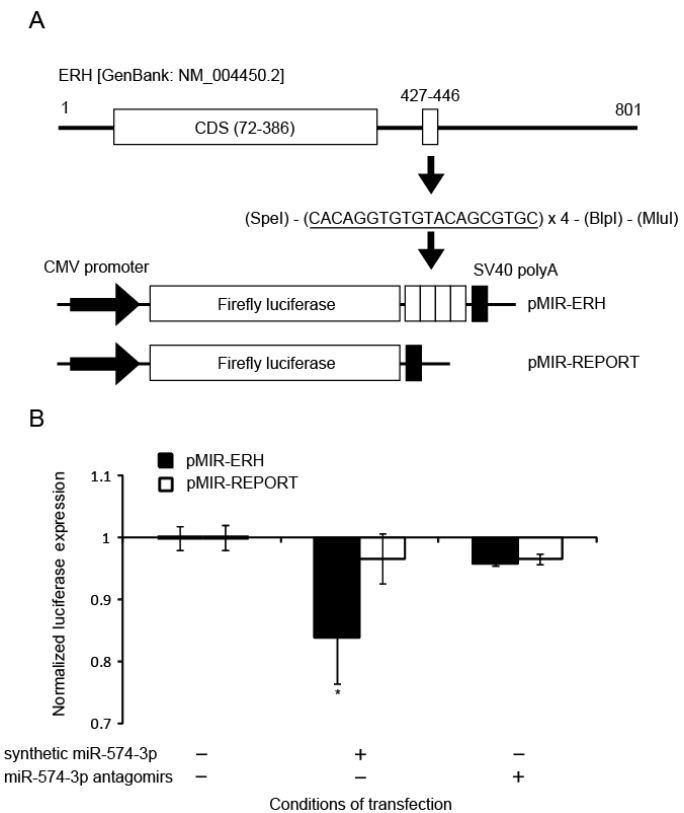
Figure 7. Luciferase reporter assay for binding of the modified ERH-3'-UTR with miR-574-3p. ( A ) The miR-574-3p target sequence was predicted to be at nucleotide positions 427 to 446 (3'-UTR) in ERH [Genbank: NM_004450.2]. The putative miR-574-3p recognition sequence (solid lines) was cloned with four repetitions downstream of the firefly luciferase gene in the pMIR-REPORT vector. Expression of the luciferase gene is controlled by the CMV promoter and SV40 polyA; ( B ) A549 cells were transfected with the pMIR-ERH plasmid or pMIR-REPORT vector without the ERH sequence as a control at 25 pM and 6 h later with synthetic miR-574-3p or the miR-574-3p antagomirs at 10 nM. Luciferase activity was measured 6 h after transfection with the synthetic miR-574-3p or miR-574-3p antagomirs. Each experiment was conducted three times. Error bars represent the standard deviation. * p < 0.05 vs . cells transfected with the pMIR-ERH